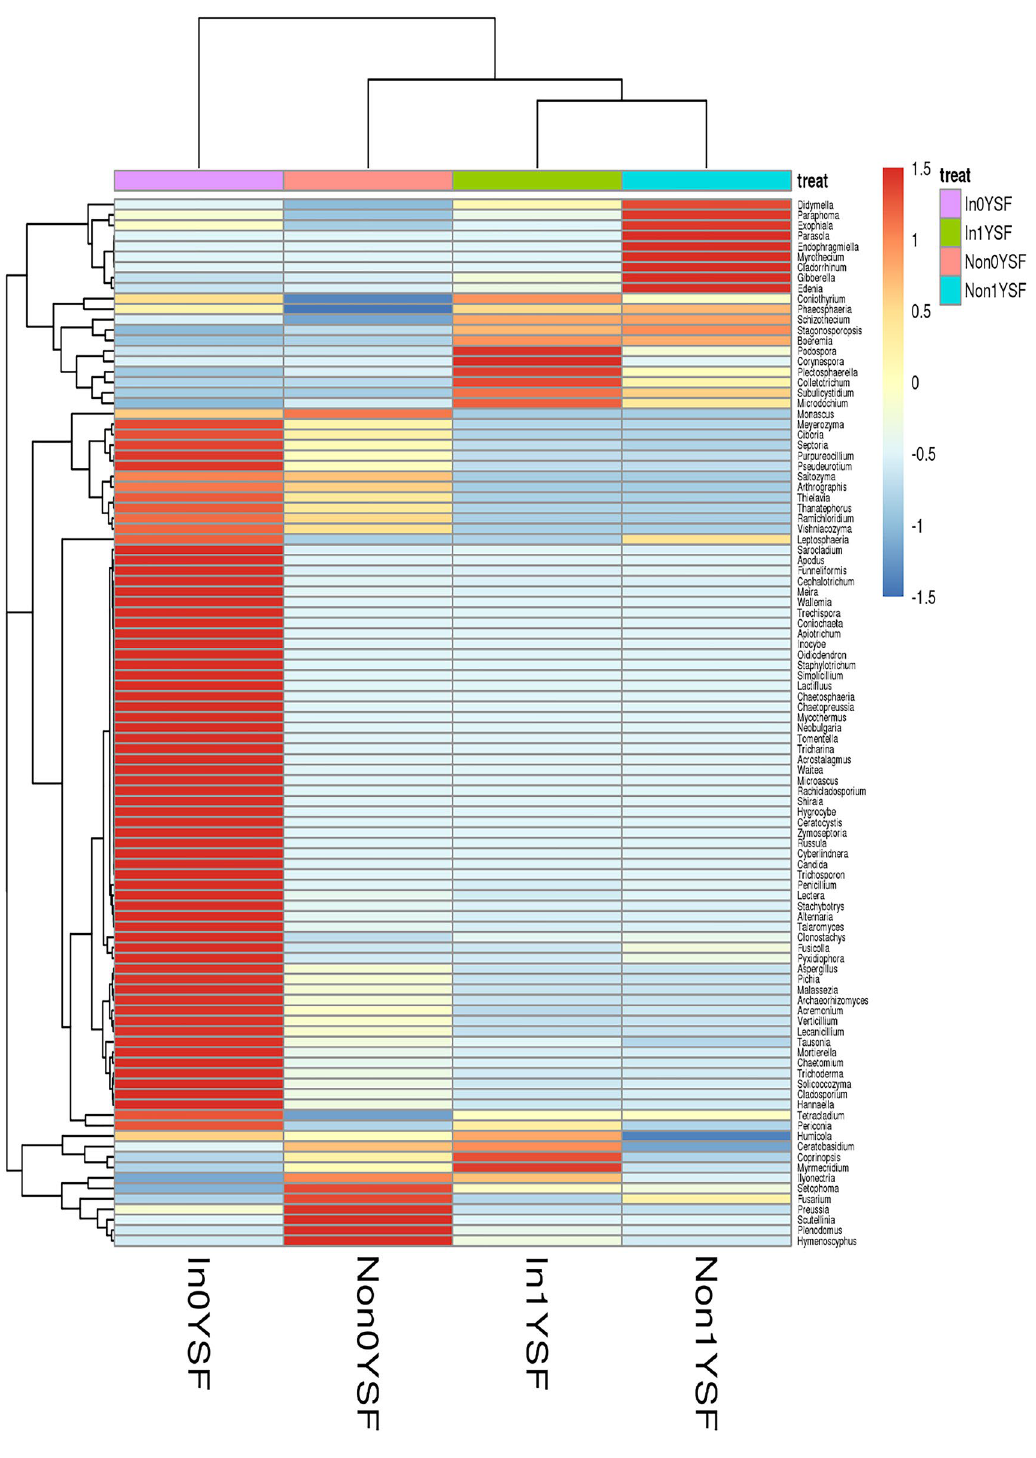
Figure 6. Heat map of the 100 most abundant fungal genera. Non represents non-inoculated with R. intraradices . In represents inoculated with R. intraradices . 0Y and 1Y represent 0 year and 1 year of continuous cropping, respectively. SF represents fungi in rhizosphere